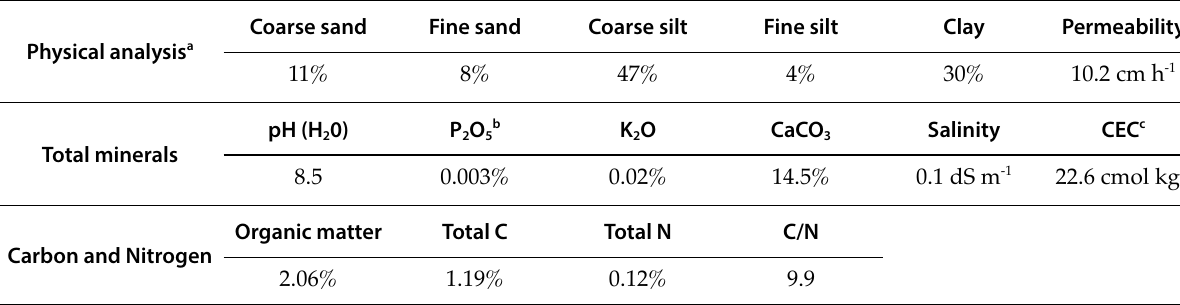
Table 1. Characteristics of soil at ITGC (Oued Smar). Physical analysis a